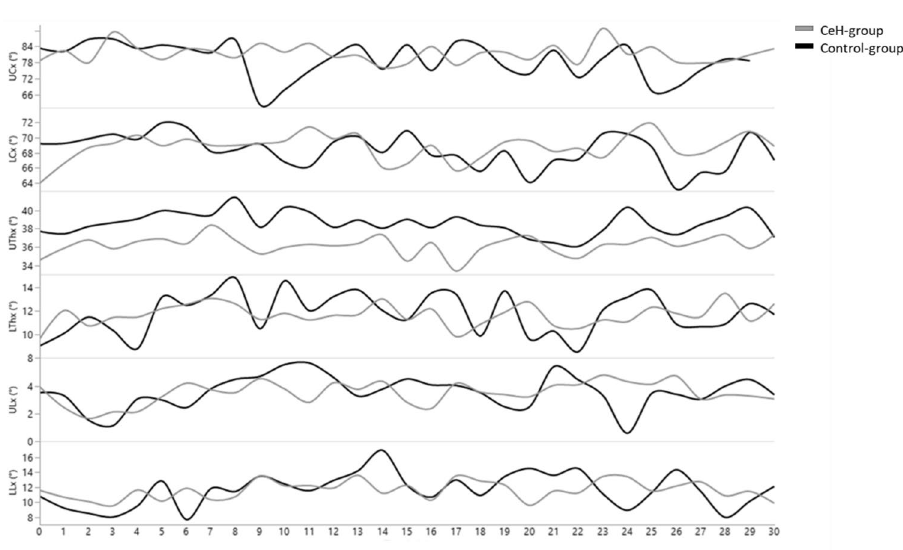
Figure 2. Visualisation of habitual spinal postures during the 30-min-laptop-task in the CeH-group and the control-group.